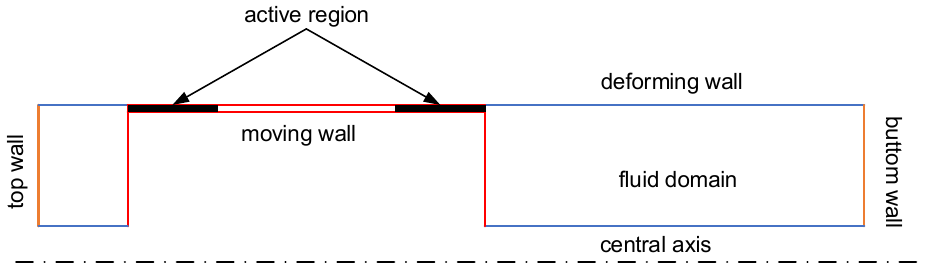
Figure 8. Diagram of moving boundaries.